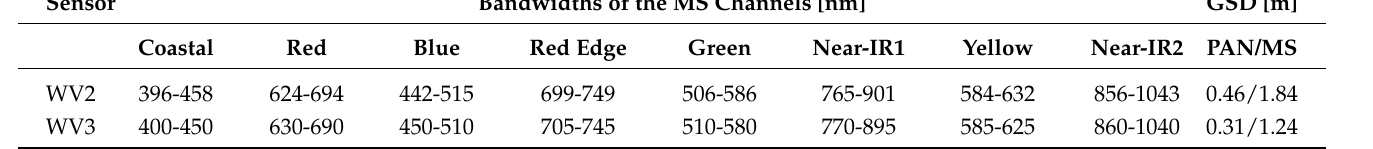
Table 1. Bandwidths of the multispectral channels (left-hand side) and Ground Sample Distance (GSD) [m] at Nadir (rightmost column) for WorldView-2 and WorldView-3 images.